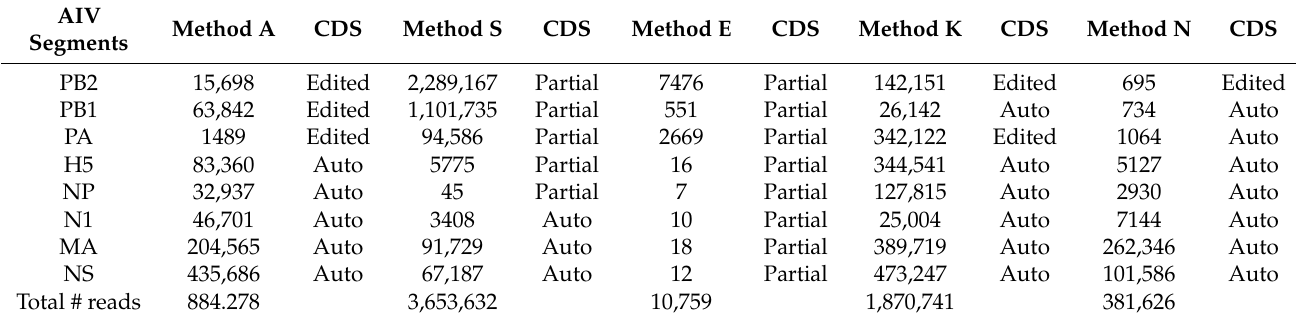
Table 4. Summary of reads generated by each method with RNA sample 246038 that mapped to HPAI H5N1. AIV segments, Avian influenza virus (AIV) RNA segments; Methods A–N, the number of reads mapped to each of the viral RNA segments by each method; Total # reads, the total number of mapped viral reads generated for each method; CDS, whether the complete coding region was assembled automatically (Auto) by the bioinformatic pipeline, or Edited, if the complete coding region was obtained following manual editing, or Partial, if the coding region was incomplete.